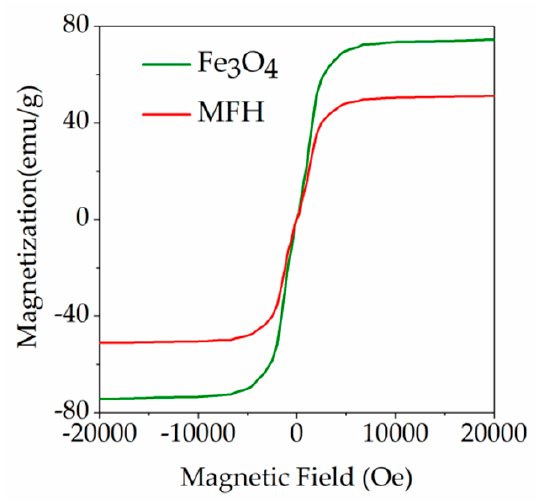
Figure 5. Magnetic hysteresis loops of Fe 3 O 4 NPs and MFH nanocomposites.